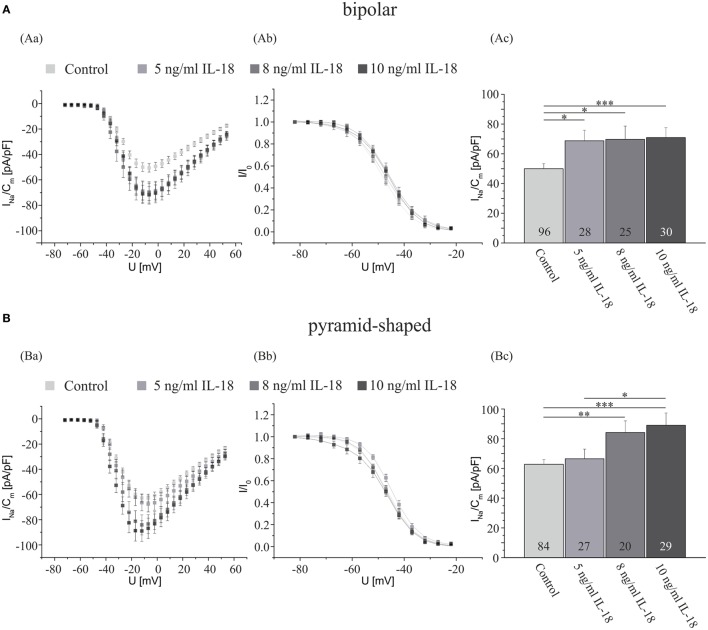
IL-18 exposure for 4 days increases the Na+ current density of cultured hippocampal neurons. Analysis of the whole data set for (A) bipolar and (B) pyramid-shaped cells. (Aa,Ba) Average current–voltage relationships for Na+ currents normalized to capacitance recorded from neurons cultured in the presence or absence of 5, 8, or 10 ng/ml IL-18 for 4 days. (Ab,Bb) Influence of IL-18 on steady-state inactivation of Na+ currents. Solid lines represent fits to the modified Boltzman equation as detailed in Section “Materials and Methods.” (Ac,Bc) Peak Na+ current densities of neurons cultured in the presence or absence of 5, 8, or 10 ng/ml IL-18 for 4 days determined at test potentials of −12 mV starting from holding potentials of −77 mV. Note that the Na+ current density increases in a dose-dependent manner. The dose–response curve for pyramid-shaped neurons is shifted toward higher concentrations. All recordings performed at day 7 in culture after incubations with test substances for 4 days following a preculture period of 3 days. Numbers in bar charts indicate numbers of cells recorded from. Database for every column derived from 7 to 24 different preparations. Since not all experiments were performed in sister cultures incubated under all four conditions the data for the control cultures in this series of experiments have been pooled. Error bars represent means ± SE, *p < 0.05, **p < 0.01, and ***p < 0.005.